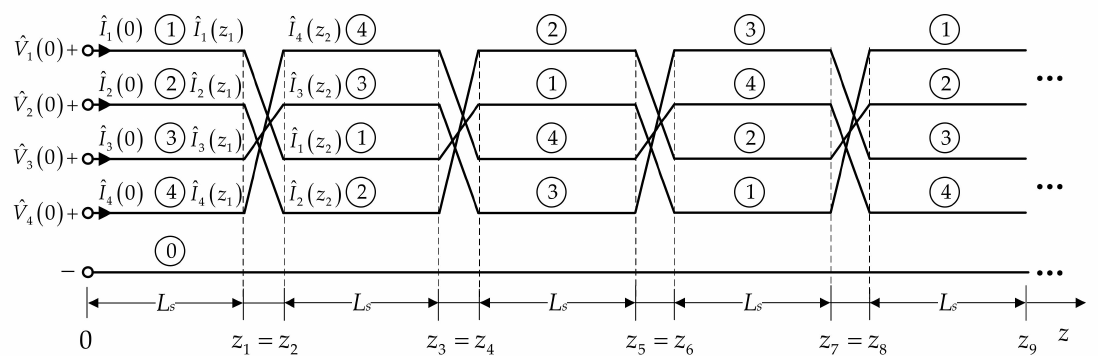
Figure 3. The abrupt transposition model of the four twisted conductors, where ˆ V i ( z )( i = 1,2,3, 4 ) represents the voltage phasor of each conductor at axial position z , ˆ I i ( z )( i = 1,2,3,4 ) represents the current phasor of each conductor at axial position z . The four twisted conductors marked as 1 (cid:13) to 4 (cid:13) are all used as signal conductors, and the conductor 0 (cid:13) represents the reference